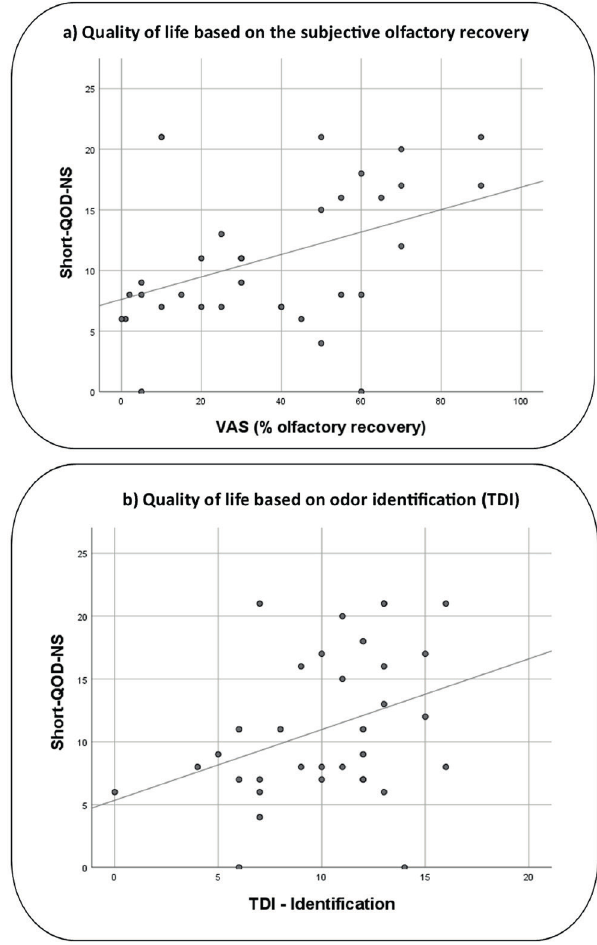
Figure 1. Correlations between quality of life (Short-QOD-NS) and per- centage of subjective odor recovery (VAS; a), and objective odor identifi- cation scores (TDI-I;